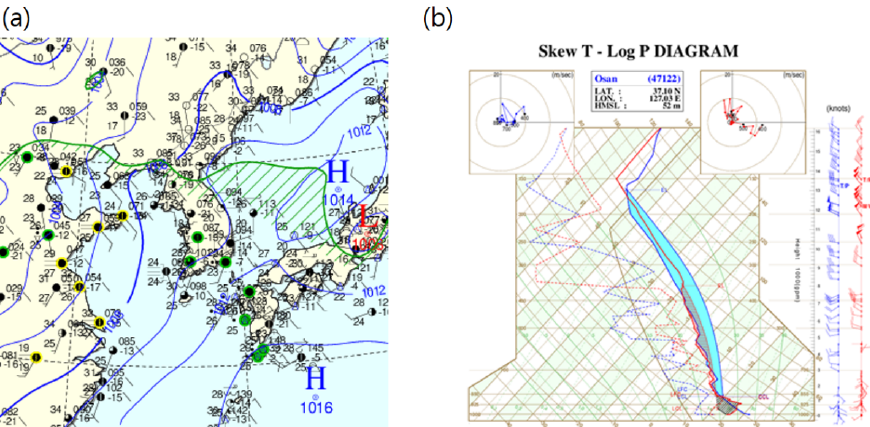
Figure 2. ( a ) Surface weather chart, and ( b ) Skew T–Log P diagram at Osan station at 1500 LST on 6 July 2017 (blue line: 1500 LST, red line: 2100 LST, solid line: temperature, dot line: dew point temperature) (Source: Korea Meteorological Administration).